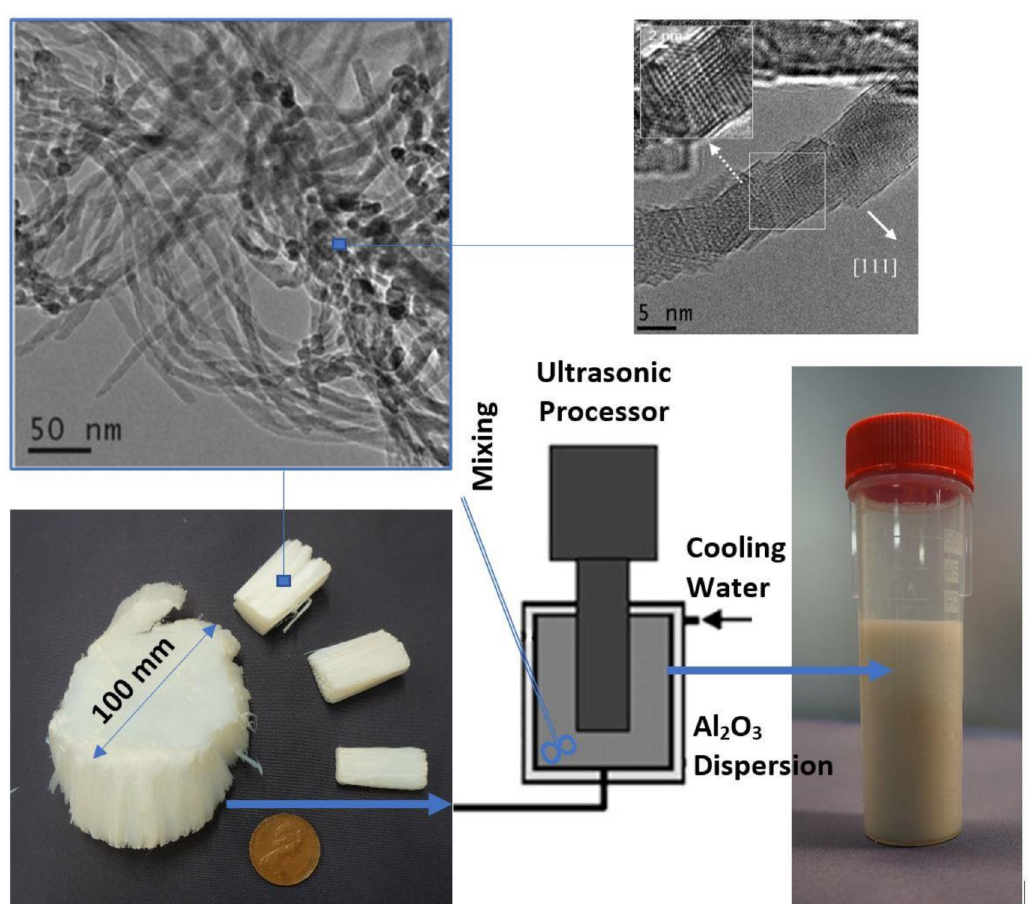
Figure 2. The dispersion of Al 2 O 3 Nanofibers: Top—Nanofibers of Al 2 O 3 (left) under SEM and TEM (right, courtesy of AFN Technologies); Bottom—The schematics of nano-Al 2 O 3 preparation from disc as received into dispersion using ultrasonic processor (left to